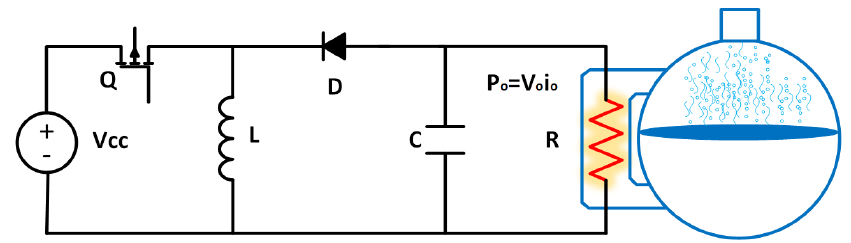
Figure 6. Scheme of the heating power